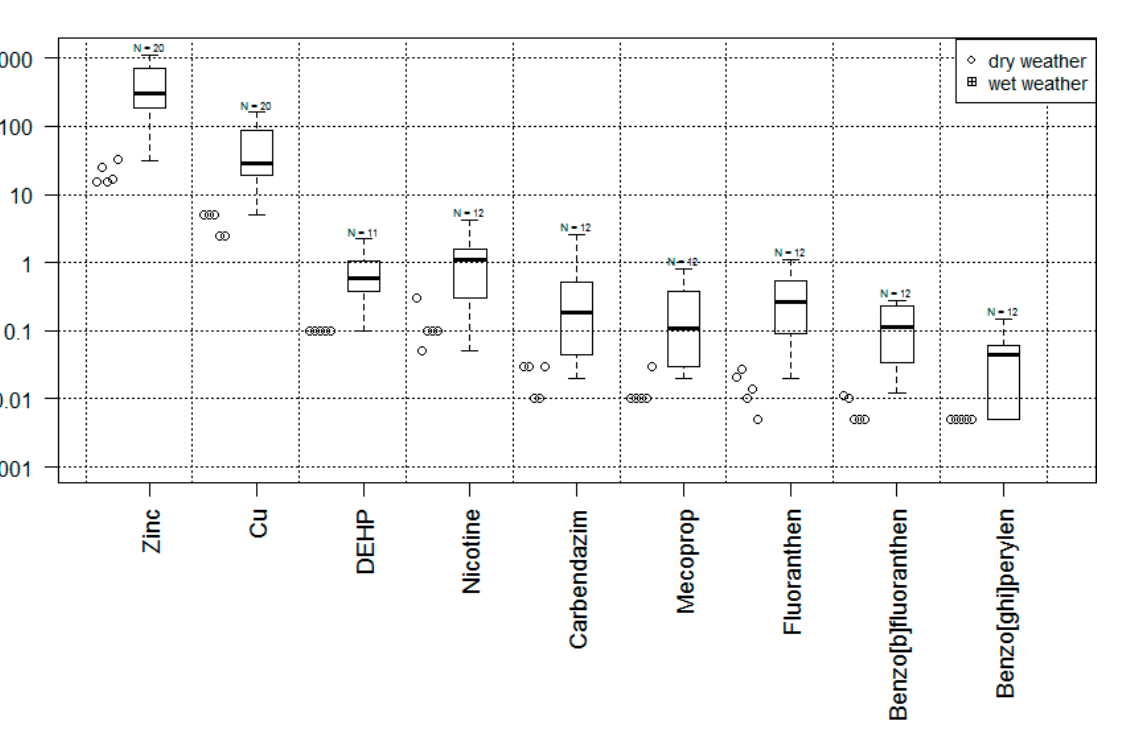
Figure 5. Concentrations of selected substances during storm events (boxplots) and dry weather (open circles) in the urban river Panke. Whiskers show minimal and maximal values.